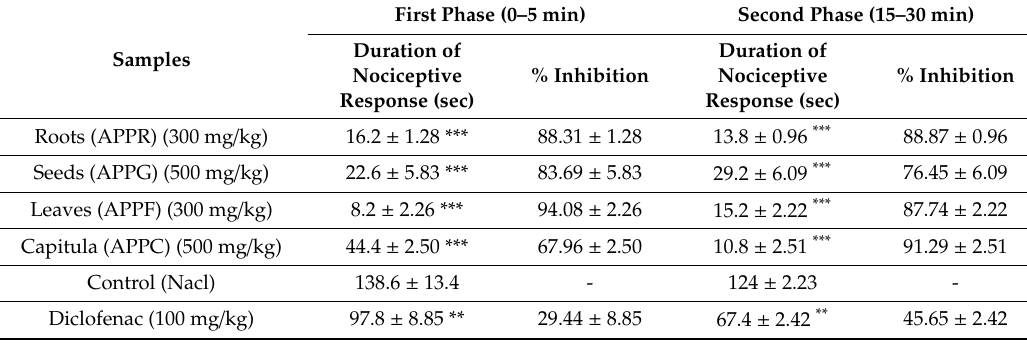
Table 2. Analgesic activity results of di ff erent parts of A. pyrethrum (L) and the e ff ect of diclofenac (100 mg / kg) on the pain (licking time) induced by the injection of formaldehyde